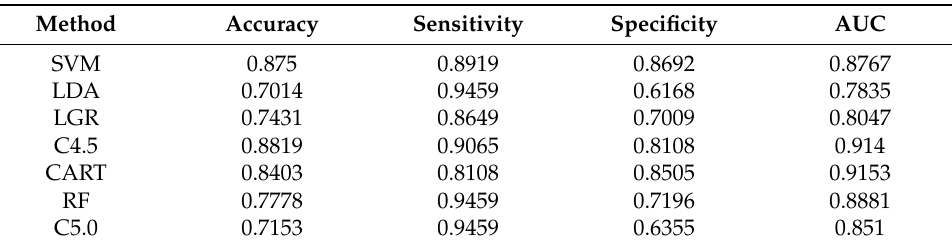
Table 4. Classification results of the seven methods with area under the curve (AUC).